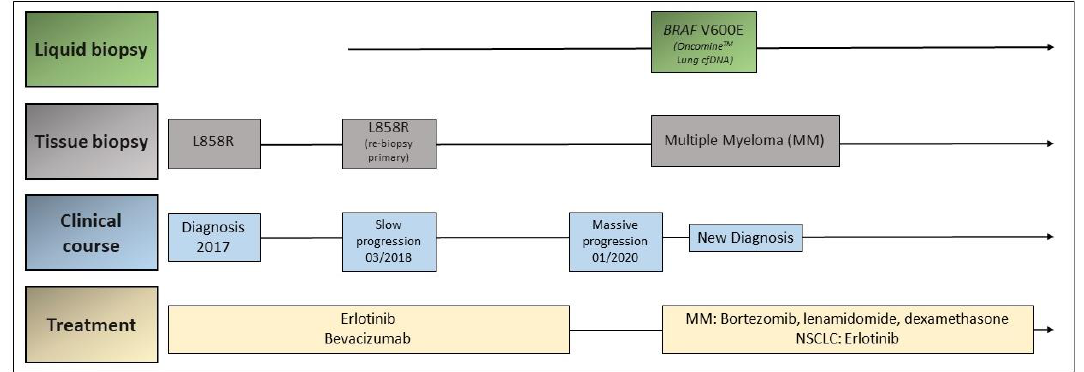
Figure 2. Timeline of disease and treatment course in case 1.